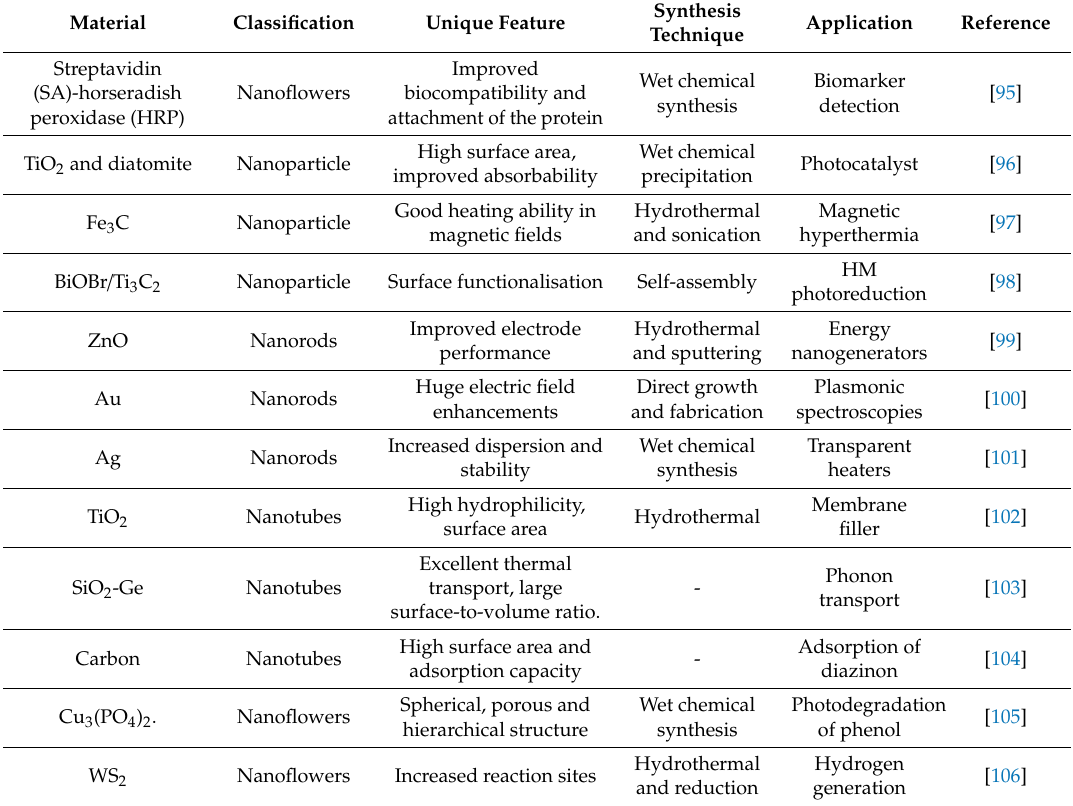
Table 2. Types of nanomaterials and the important features they exhibit as compared to bulk material.